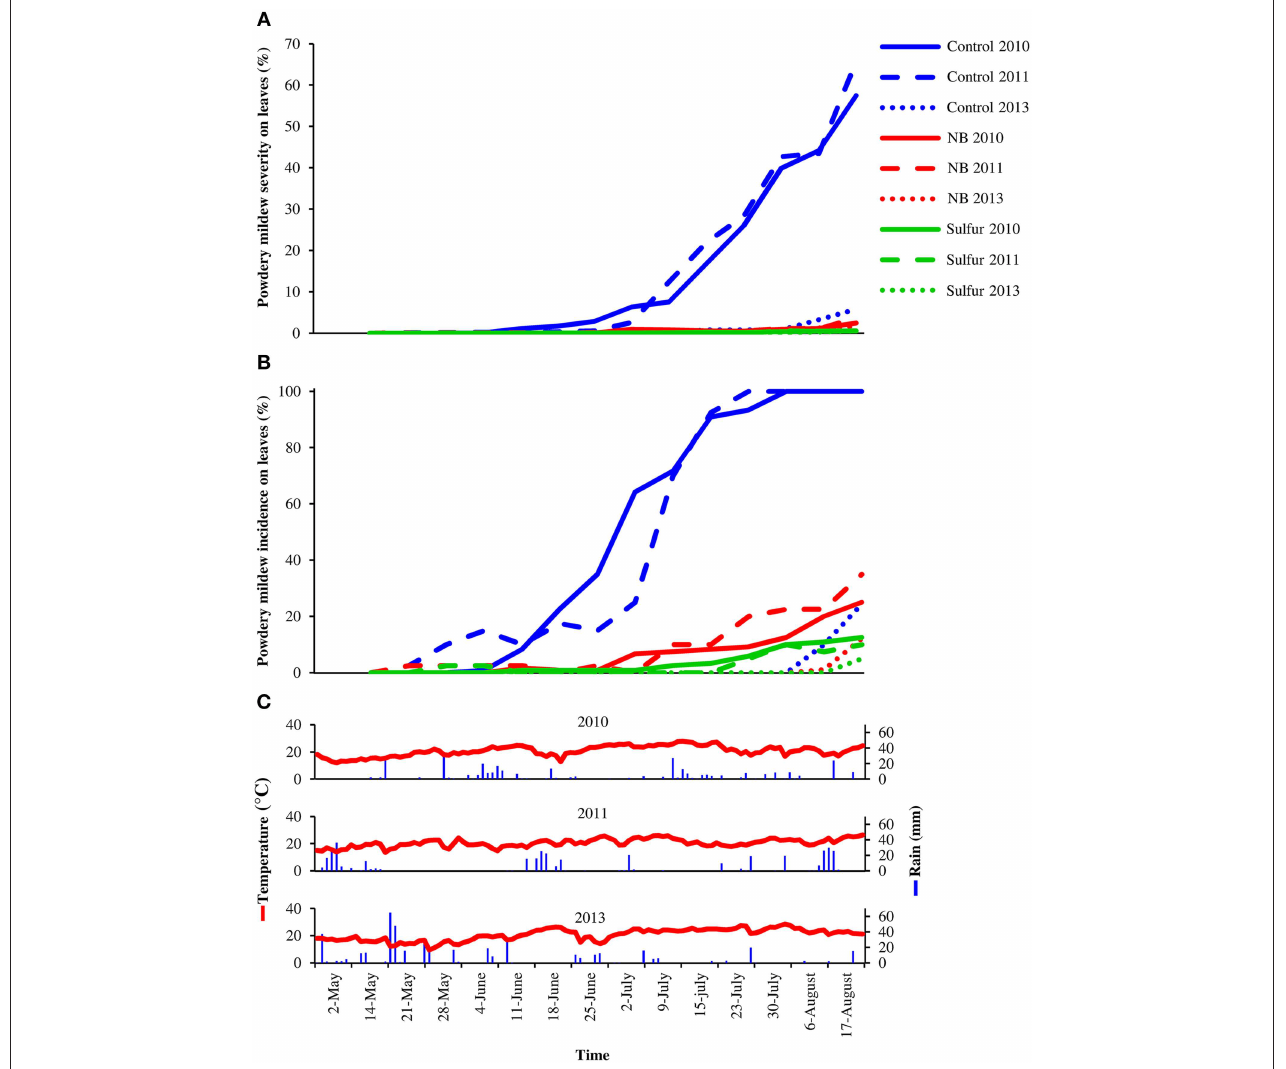
FIGURE 1 | Effect of nutrient broth against powdery mildew on grapevine leaves under field conditions. Powdery mildew severity (A) and incidence (B) was assessed on leaves of grapevine plants treated with water (Control), nutrient broth (NB) or sulfur (Sulfur), as standard fungicide, under field conditions in three different seasons (2010, 2011, and 2013). Treatments were applied weekly from the beginning of May to the middle of August. Disease severity and incidence were assessed weekly as percentage of adaxial leaf area covered by white sporulation and percentage of leaves showing symptoms by scoring 40 leaves per replicate, respectively. The mean severity and incidence scores of three replicates (eight plants each) are presented for each treatment. The temperature and rain during the seasons were recorded by a meteorological station (C) . The dosage of NB was 5.0g/l in 2010, and was reduced to 3.0g/l in 2011 and 2013 to avoid phytotoxicity.